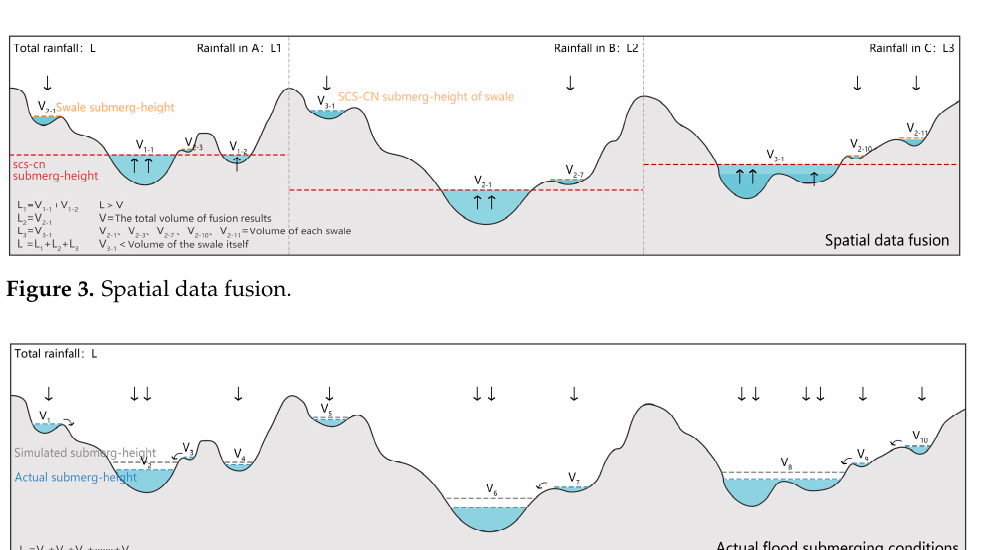
Figure 4. Actual flood-submerged conditions.